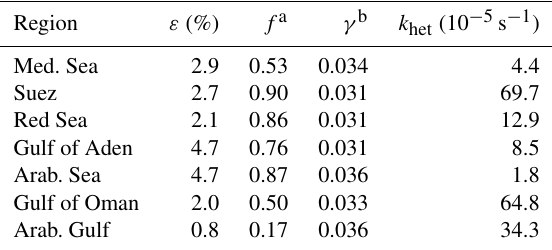
Table 2. Regional variability in ClNO 2 production efficiency ( ε ), ClNO 2 yield ( f ), N 2 O 5 uptake coefficient ( γ ), and heterogeneous NO 3 loss rate ( k het